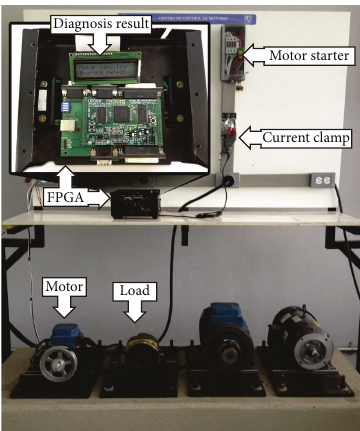
Figure 14: Experimental